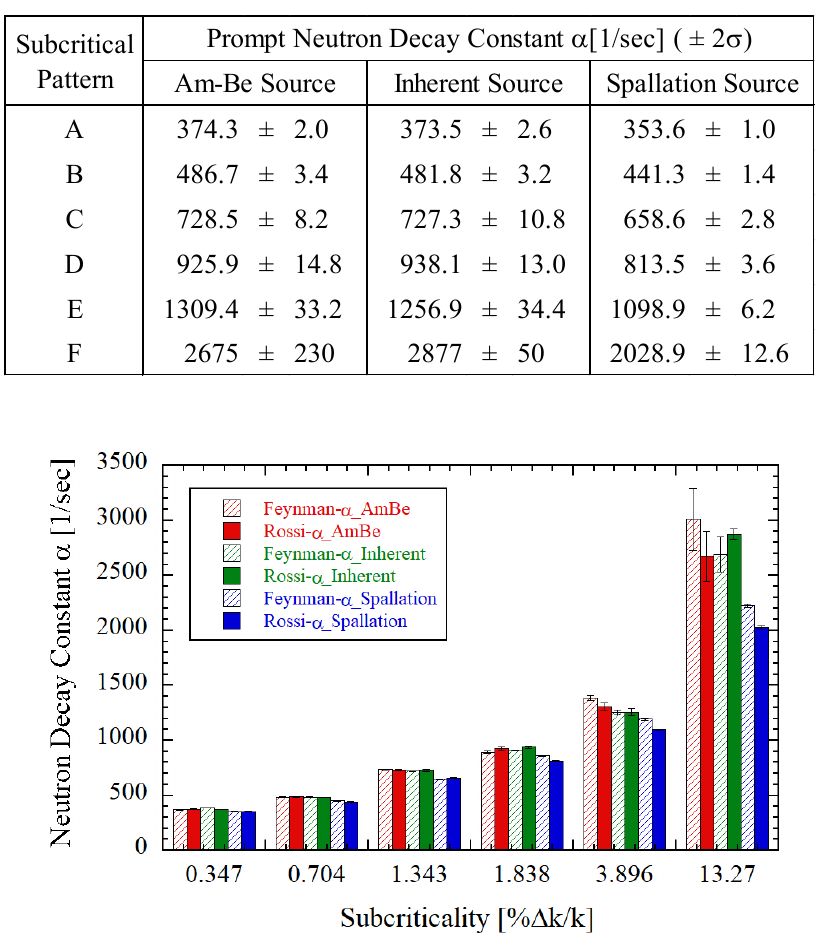
Figure 8. Comparison of the prompt decay